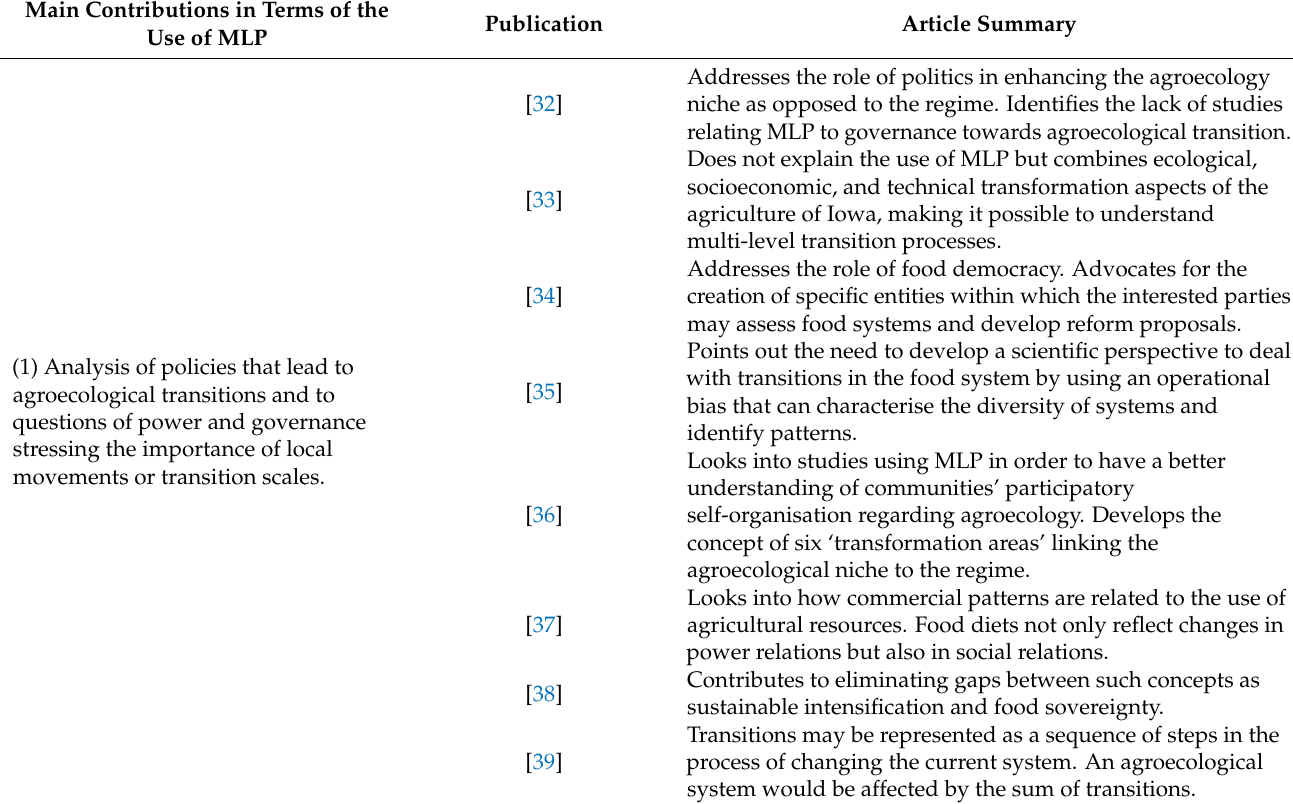
Table 1. Multi-Level Perspective (MLP) applications and its analytical levels and associated concepts in agroecological transition